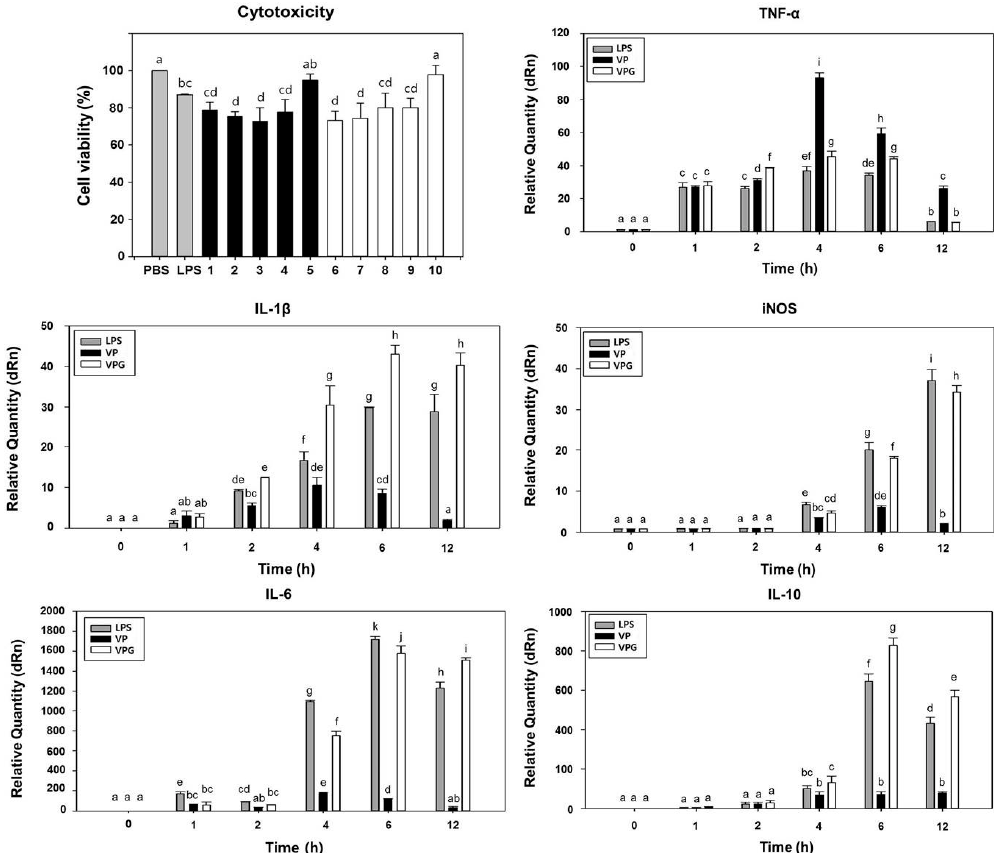
Figure 3. VPGs-exposed murine macrophage (RAW 264.7) shows cell viability and stimulates both pro- and anti-inflammatory cytokine production. To determine cytotoxicity, macrophages were exposed to PBS buffer, LPS from Escherichia coli , V. parahaemolyticus wild-type cells (bars 1–5), and VPGs treated with NaOH for 60 min (bars 6–10), respectively. At 24 h post-exposure, macrophages were collected for analysis of cell viability using Cell counting Kit-8. Bars represent exposure doses of 2.5 × 10 6 (1 and 6), 1.7 × 10 6 (2 and 7), 1.3 × 10 6 (3 and 8), 1.0 × 10 6 (4 and 9), and 0.5 × 10 6 (5 and 10) CFU/mL, respectively. Absorbance was measured at 450 nm and all experiments were performed in triplicate. Cytotoxic activity is expressed as the percentage of cell viability by the formula described in Materials and Methods. At 4 h post-exposure with LPS from Escherichia coli , V. parahaemolyticus wild-type cells (VP), and NaOH-induced VPGs for 60 min, respectively, macrophages were collected for analysis of gene expression for cytokines TNF- α ; IL-1 β ; iNOS; IL-6; and IL-10 using RT-qPCR. Data are representative of triplicate experiments with each sample run in triplicate. All data are expressed as the mean ± the standard error of the mean. Mean separation by Duncan’s multiple range test at p < 0.05. The same letter above bars represented no significant difference between treatments.